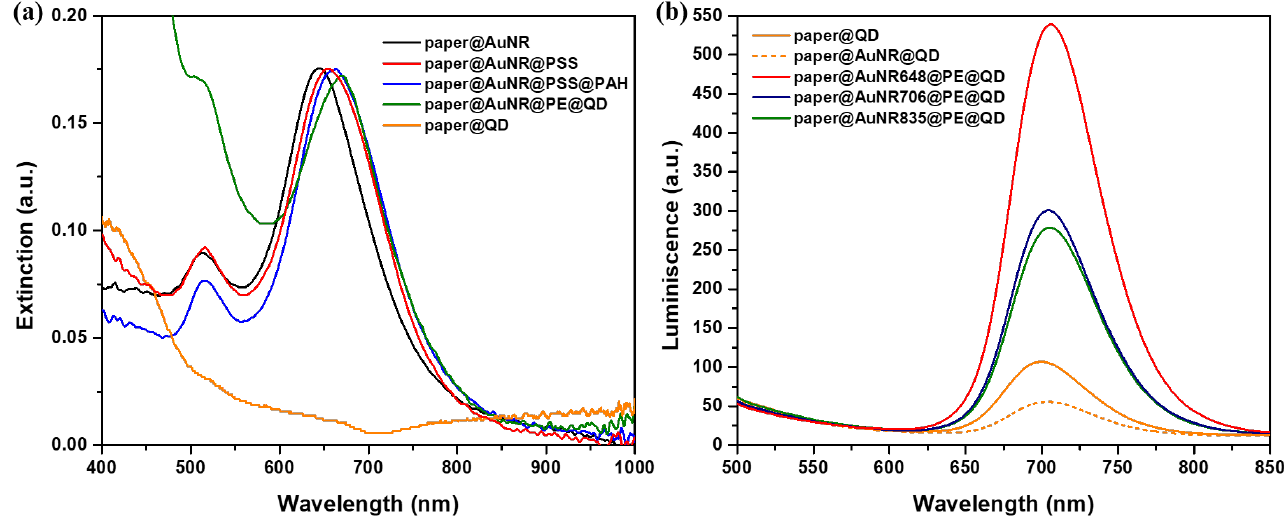
Figure 3. ( a ) Extinction spectra of the paper@AuNR648 nanoplatform before (black spectrum) and after being coated first with PSS (red spectrum), followed by PAH (blue spectrum), and after decorating with QD (green spectrum), together with the absorption spectra of QD on bare paper (orange spectrum), using the same concentration and experimental condition. ( b ) Luminescence spectra of paper@QD (orange spectrum), paper@AuNR@QD (orange dashed spectrum), and QD decorated on